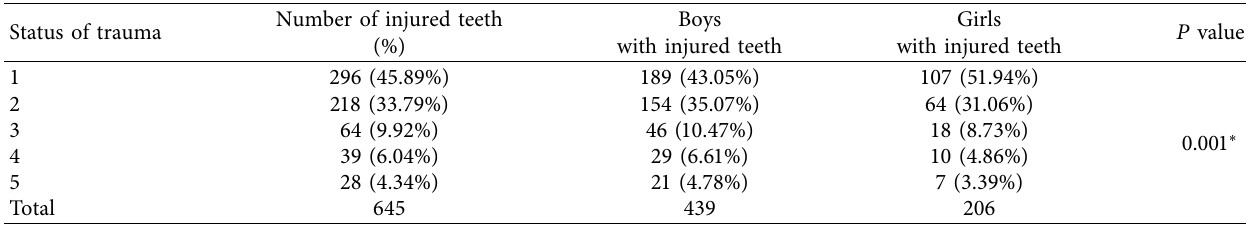
Table 3: Te frequency distribution of types of traumatic dental injuries in school children.